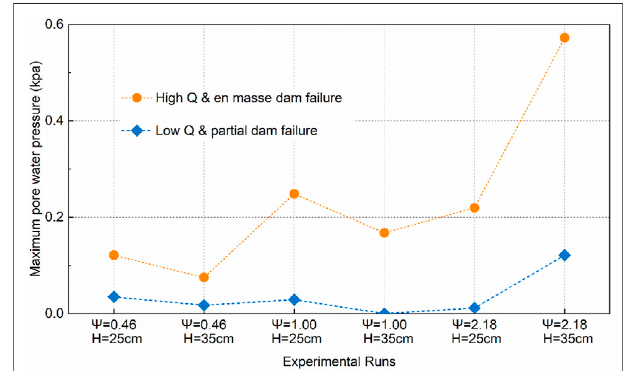
FIGURE 7 | Maximum pore water pressure measured for partial and en masse failed dam in comparative runs characterised with the same vertical grading parameter and dam